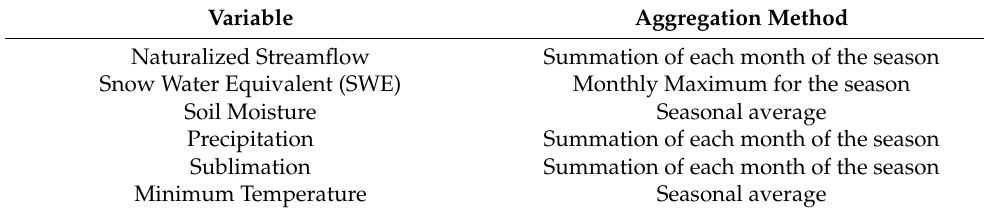
Table 3 . The data aggregation method for seasonal analysis .